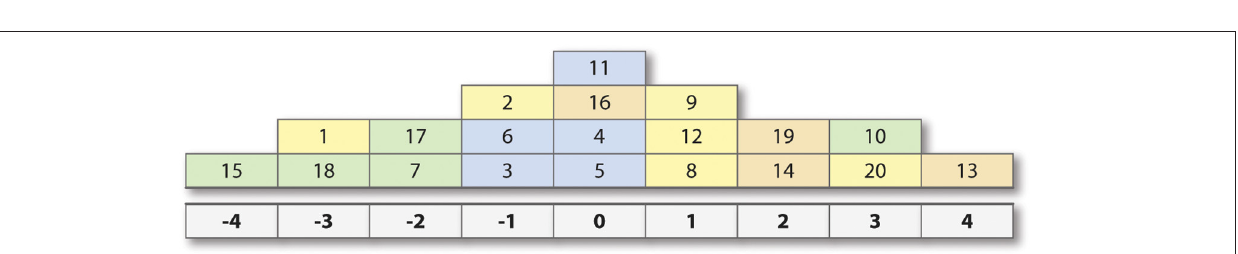
FIGURE 5 | Ideal sort for factor 3. Factor name was chosen based on statements 15 and 13. Color coding is based on the four pillars of sustainability (green = biological sustainability, blue = economic sustainability, Red = social sustainability, and yellow = institutional